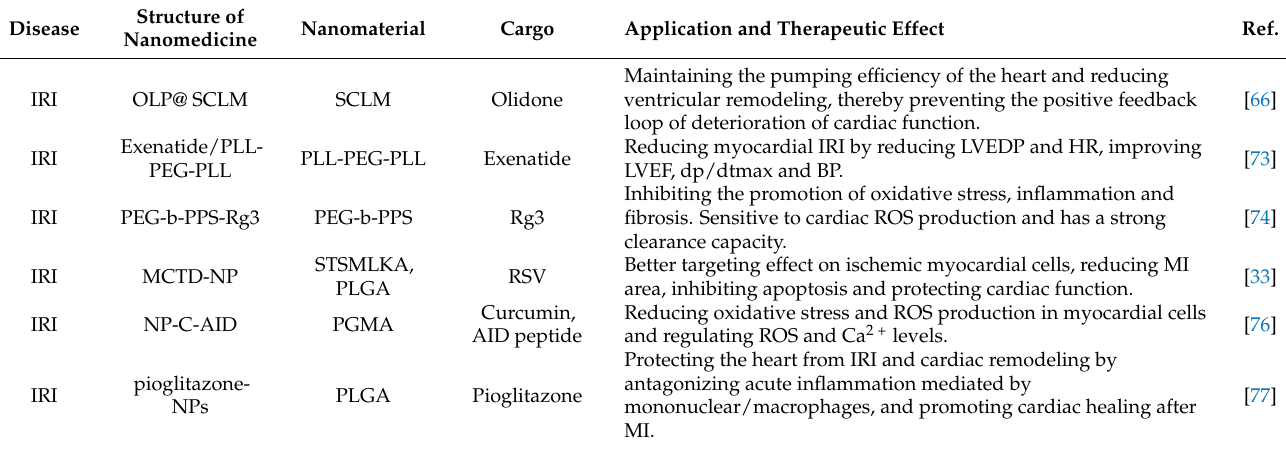
Table 2. Different approaches based on nanoparticles for the treatment of